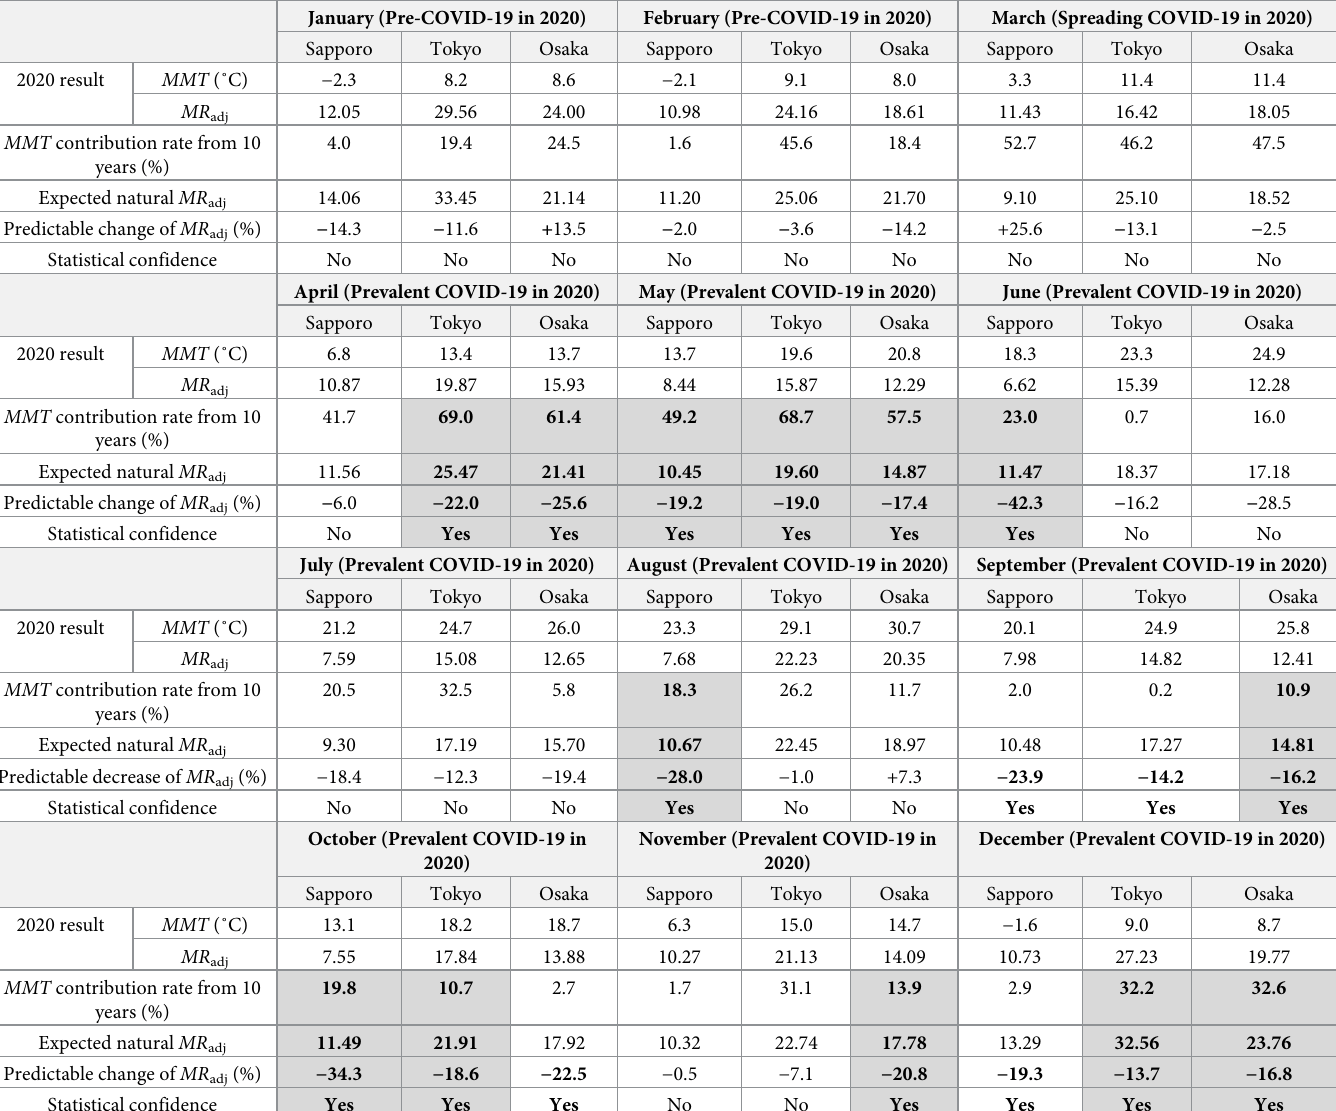
Table 2. Predictable changes in MR adj for acute ischaemic heart disease (IHD) estimated in this